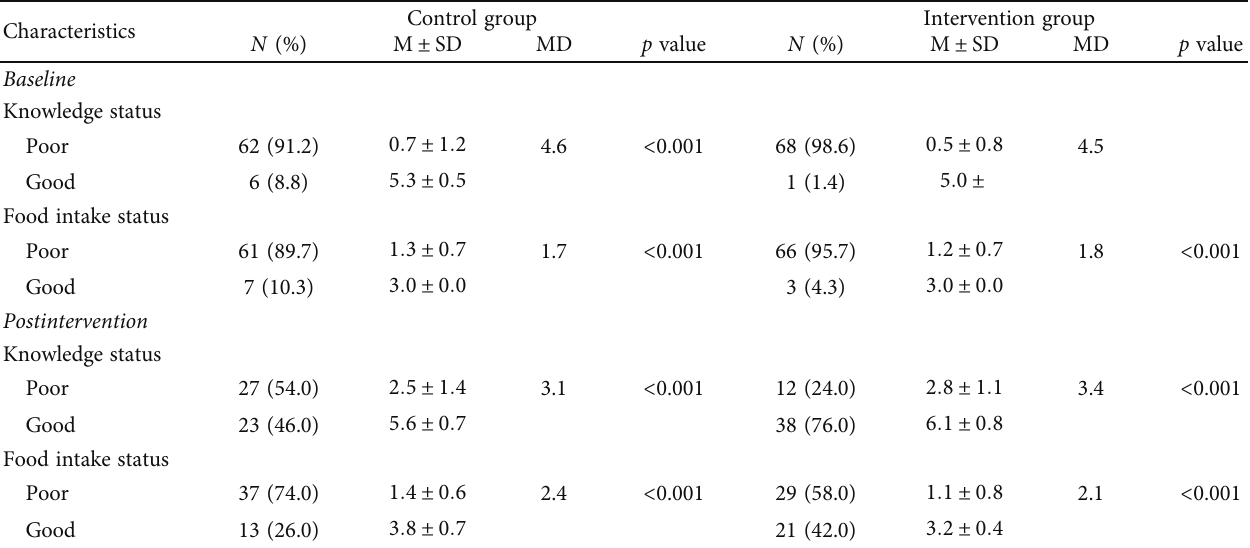
Table 4: Knowledge status and knowledge scores, iron-rich food intake status, and food intake scores within the study groups.